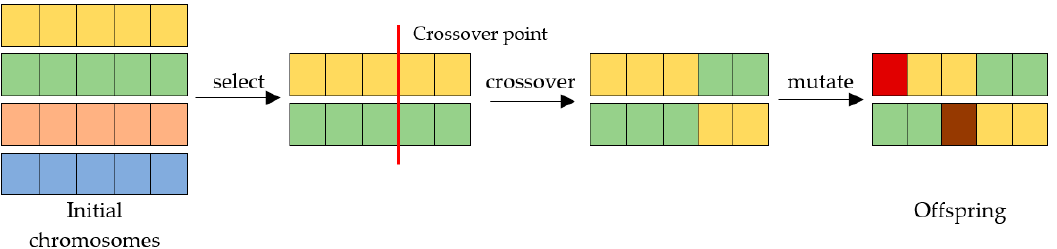
Figure 2. The three basic genetic operators within a GA.